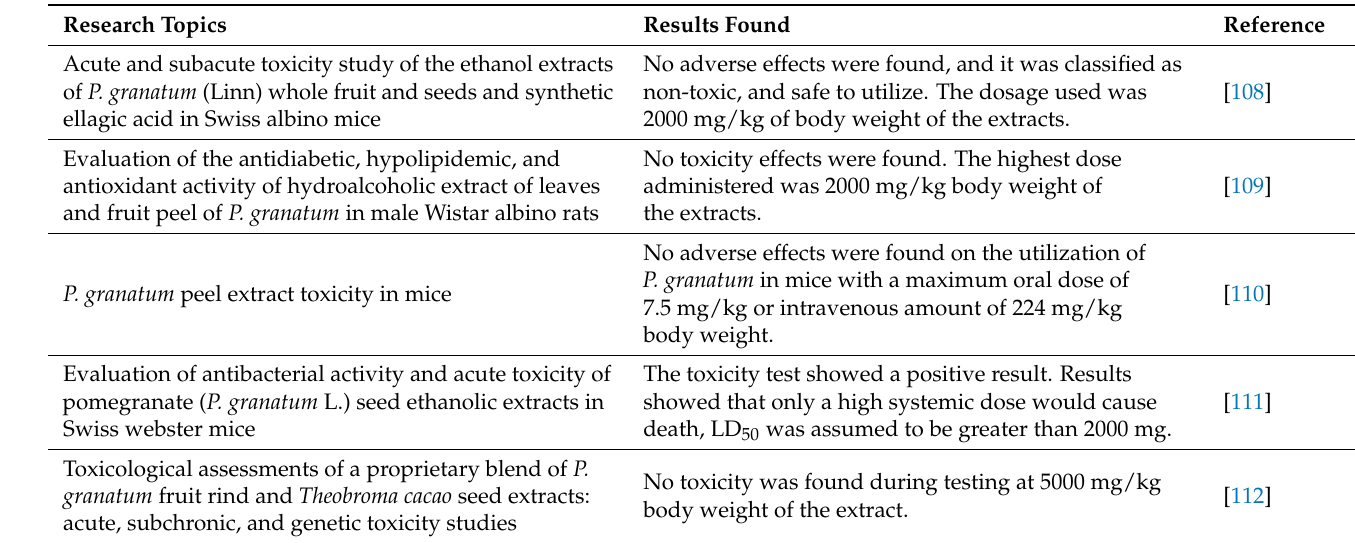
Table 3. Toxicity studies of P. granatum